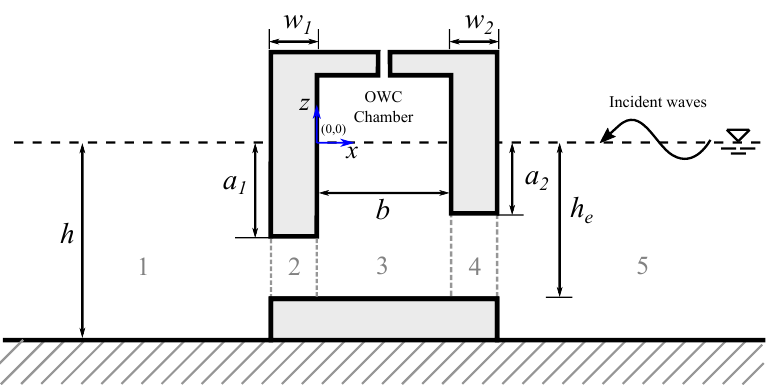
Figure 1. Side view of the interaction of a fixed-detached OWC device with water waves. The fluid is inviscid and incompressible and the flow is irrotational; thus, the ve- locity potential theory is applied. The wave motion is represented by linearized wave theory, disregarding surface tension effects. A simple harmonic flow with angular fre- quency ω is assumed, where the velocity potential is defined by Φ ( x , z , t ) with Φ ( x , z , t ) = Re { φ ( x , z ) e − i ω t } , with Re { } denoting the real part of a complex expression. Under